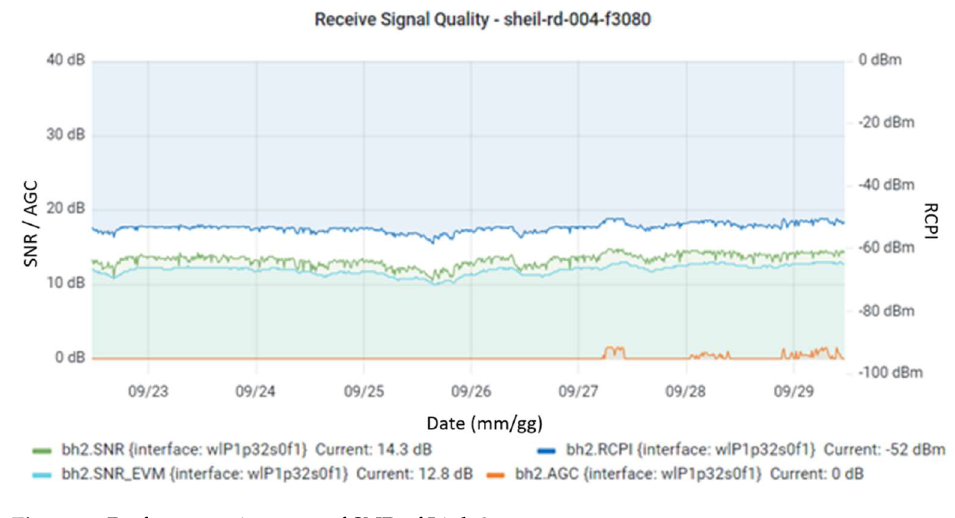
Figure 7. Performance in terms of SNR of Link 2.